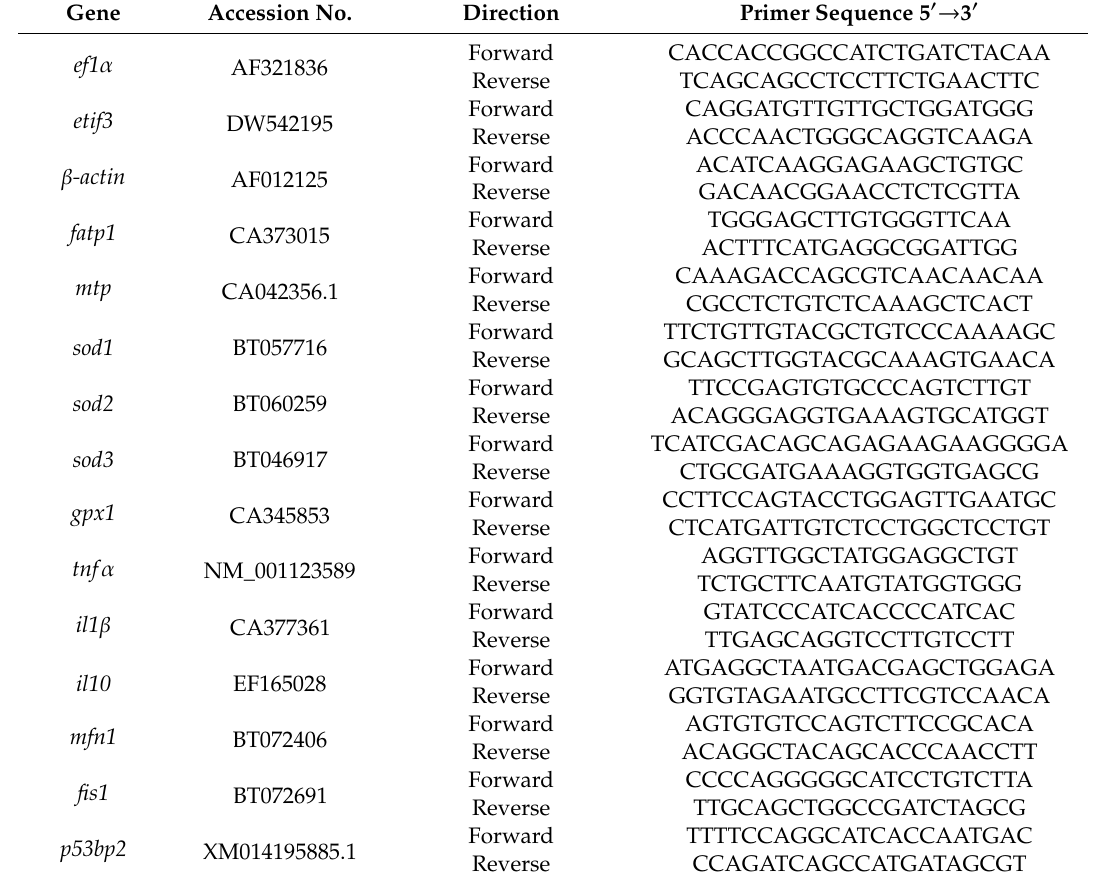
Table 2. Atlantic salmon primer sequences used for real-time